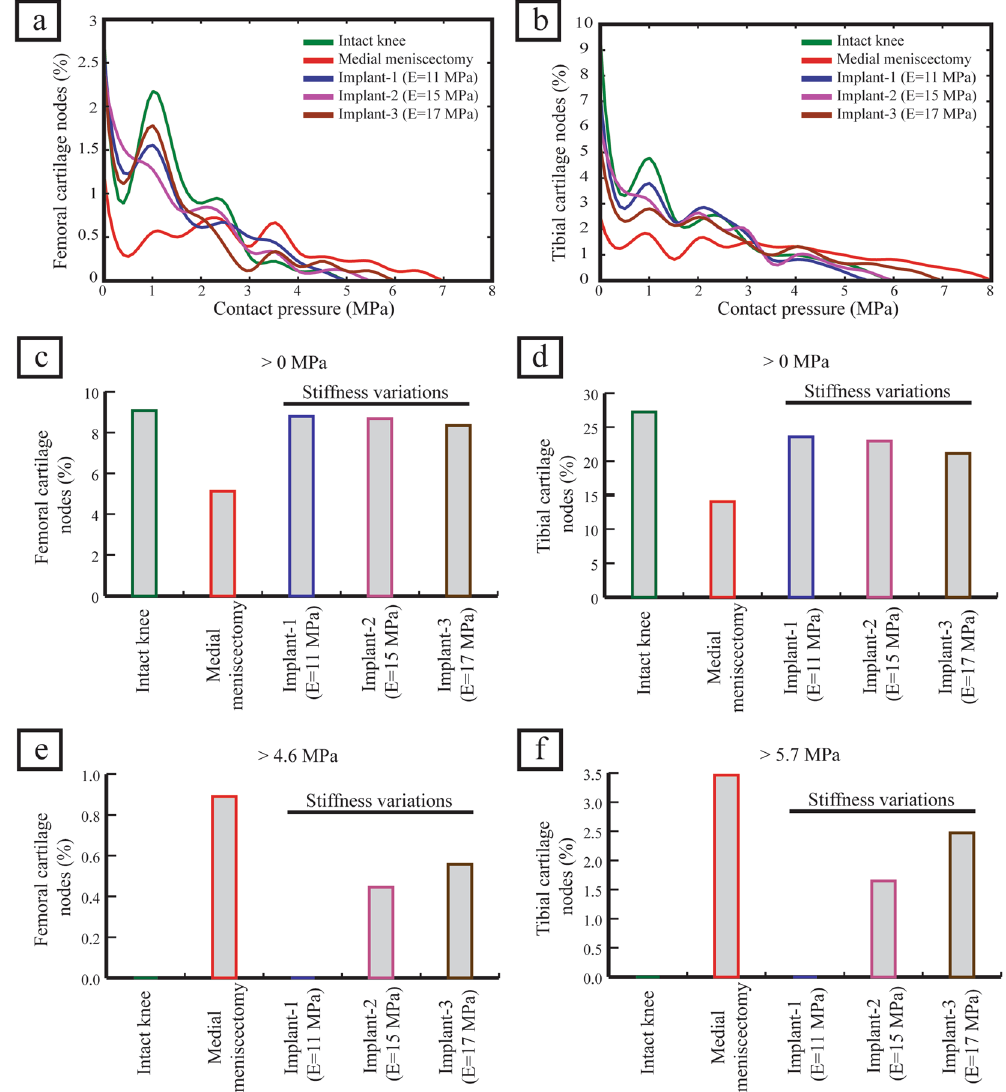
Figure 3. Analysis of articular cartilage contact pressure. ( a,b ) the cartilage contact pressure for each node (only non-zero values were included), ( c,d ) the percentage of cartilage nodes loaded with contact pressure greater than 0 MPa (reflects the loaded cartilage area), ( e ) the percentage of femoral cartilage nodes loaded with contact pressure greater than 4.6 MPa (peak femoral cartilage contact pressure induced by the intact knee), and ( f ) the percentage of tibial cartilage nodes loaded with contact pressure greater than 5.7 MPa (peak tibial cartilage contact pressure induced by the intact